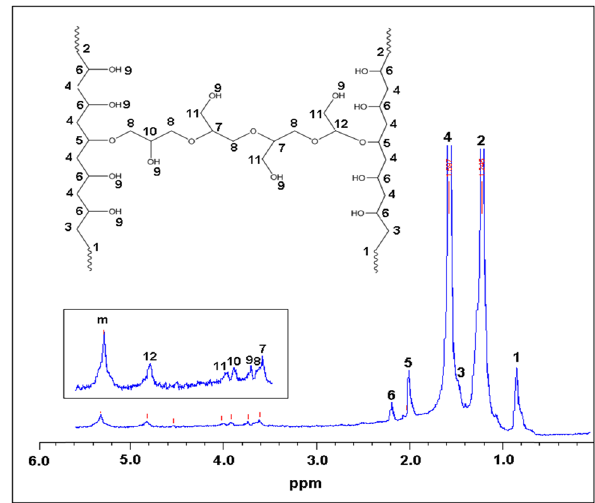
Figure 7: 1 HNMR spectrum of the reinforced PVA